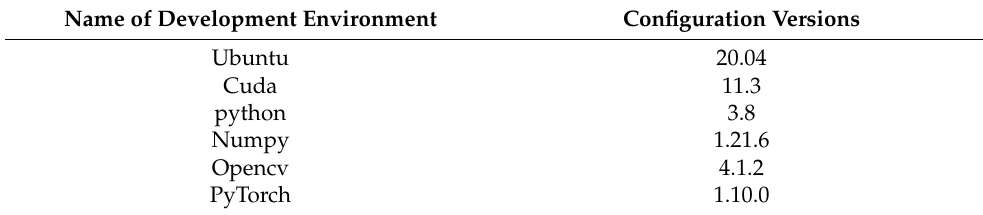
Table 1. Partial environment configuration table required for the